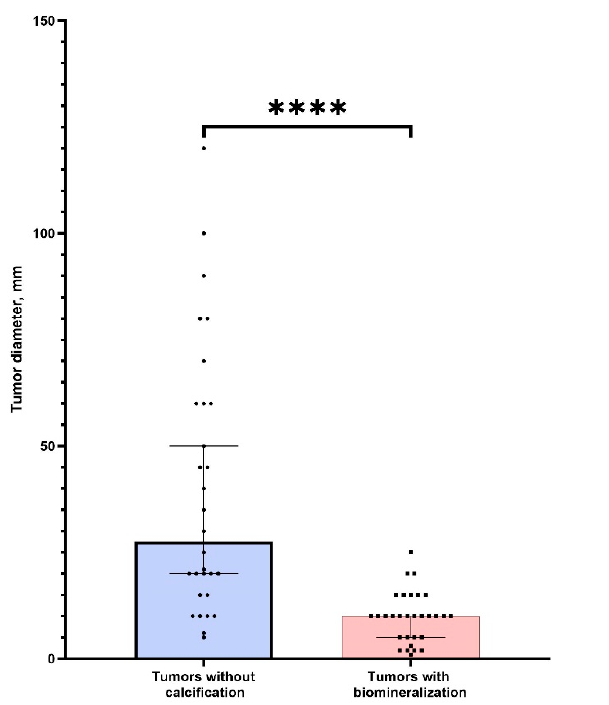
Figure 7. The comparison of tumor sizes (larger diameter) in groups of samples with the presence and absence of calcification. **** corresponds ( p < 0.0001).